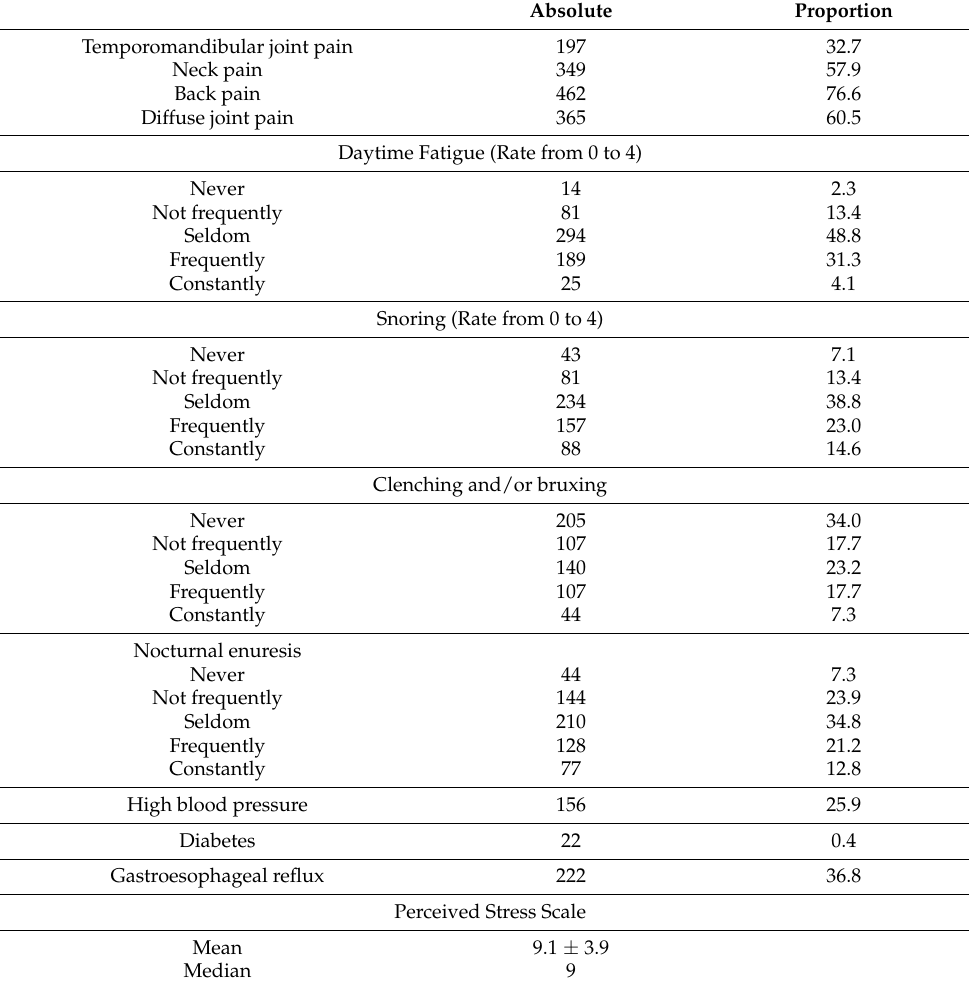
Table 5. Presence of medical problems in the sample ( n =